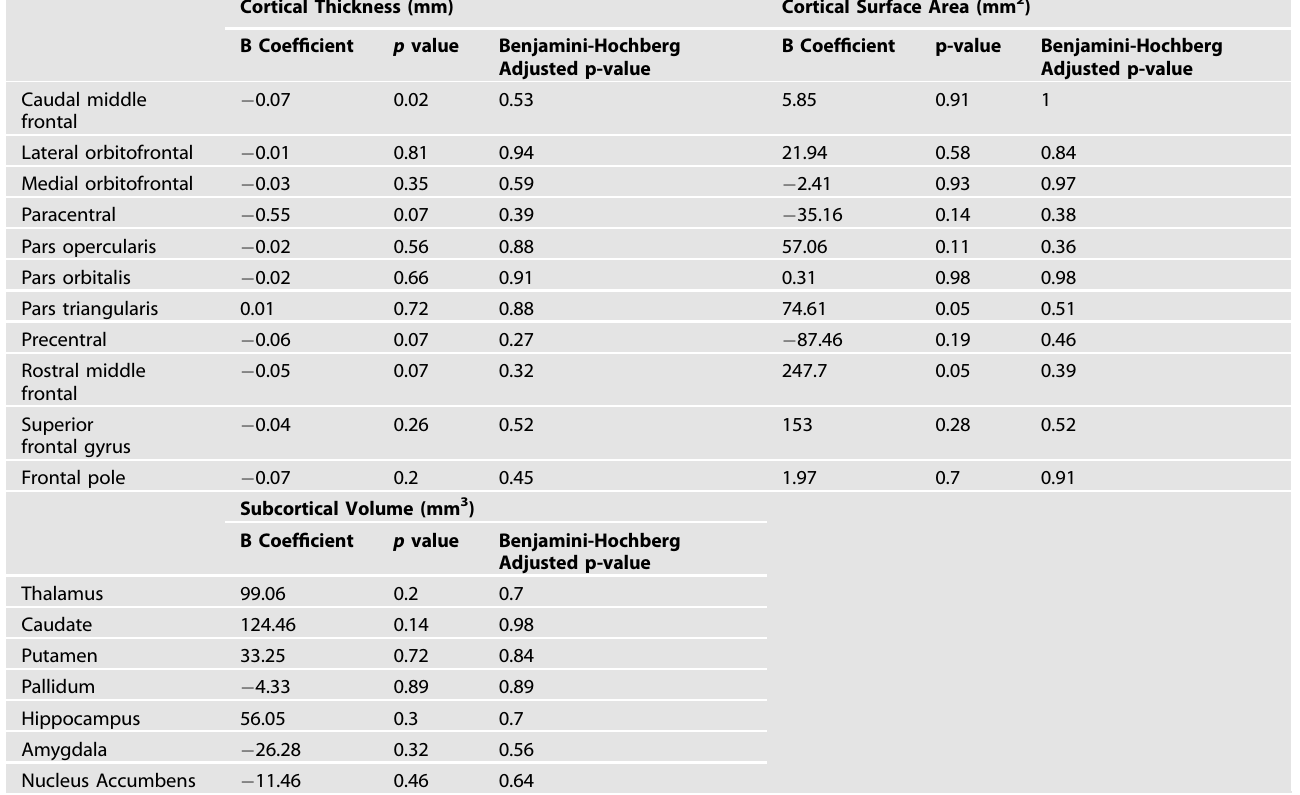
Table 2. Antenatal depressive symptom associations with cortical thickness, cortical surface area and subcortical